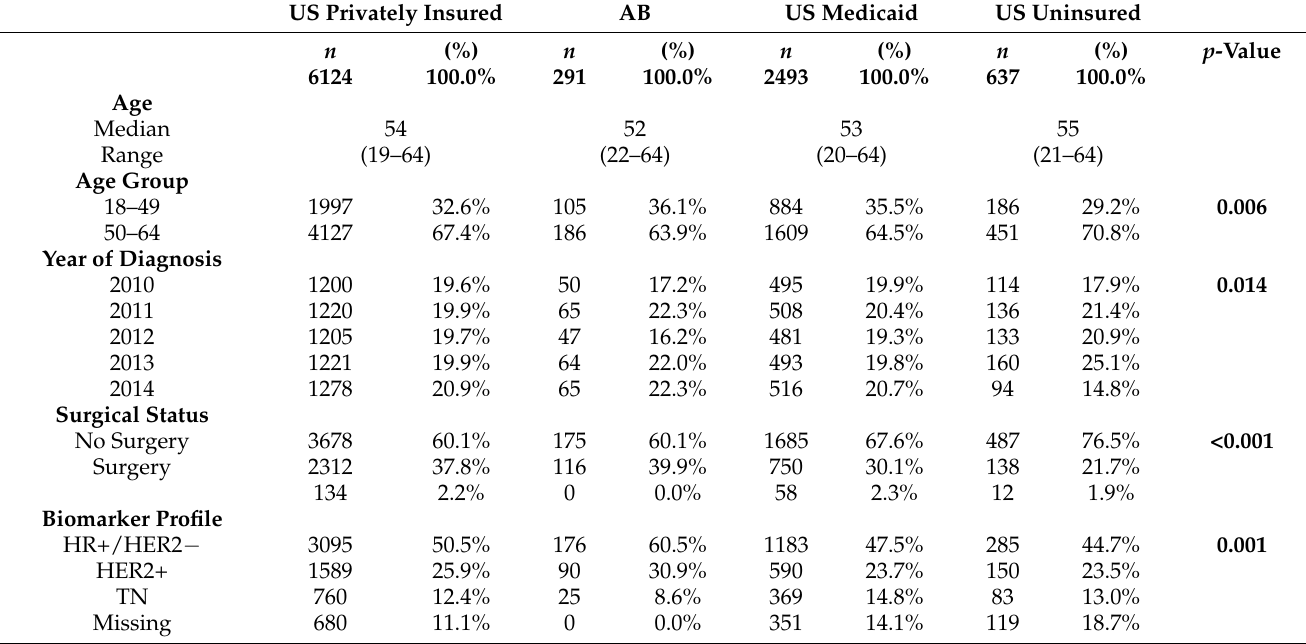
Table 1. Comparison of US Cohort by Insurance Status and AB